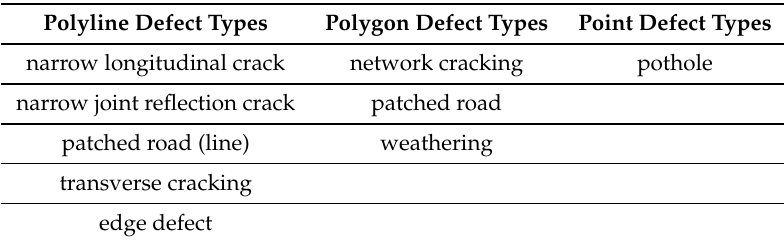
Table 4. Types of pavement defects.